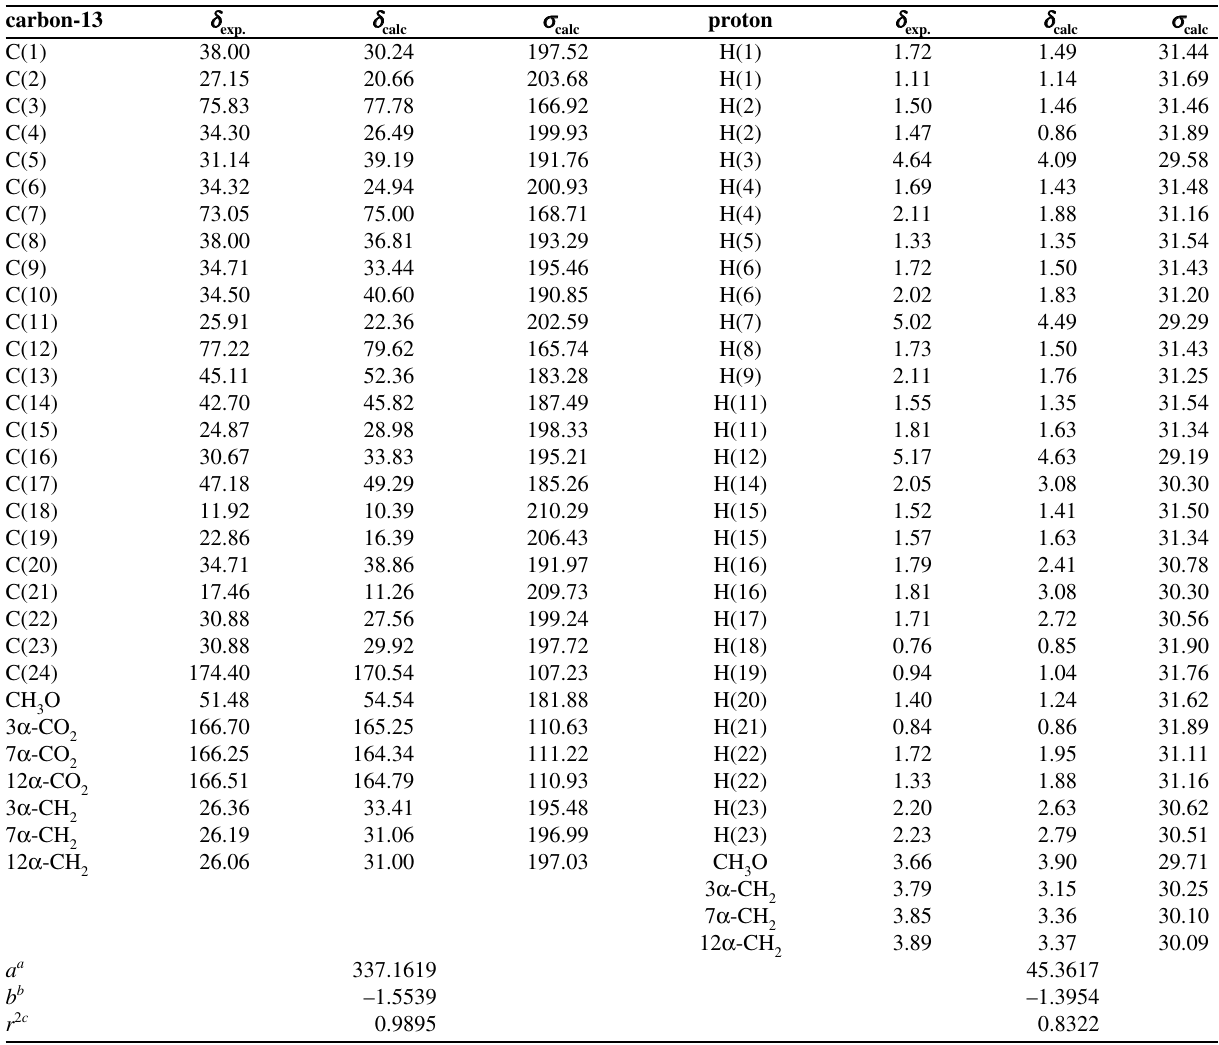
Table 4. Chemical shifts ( δ , ppm) in CDCl were computed from the linear equation